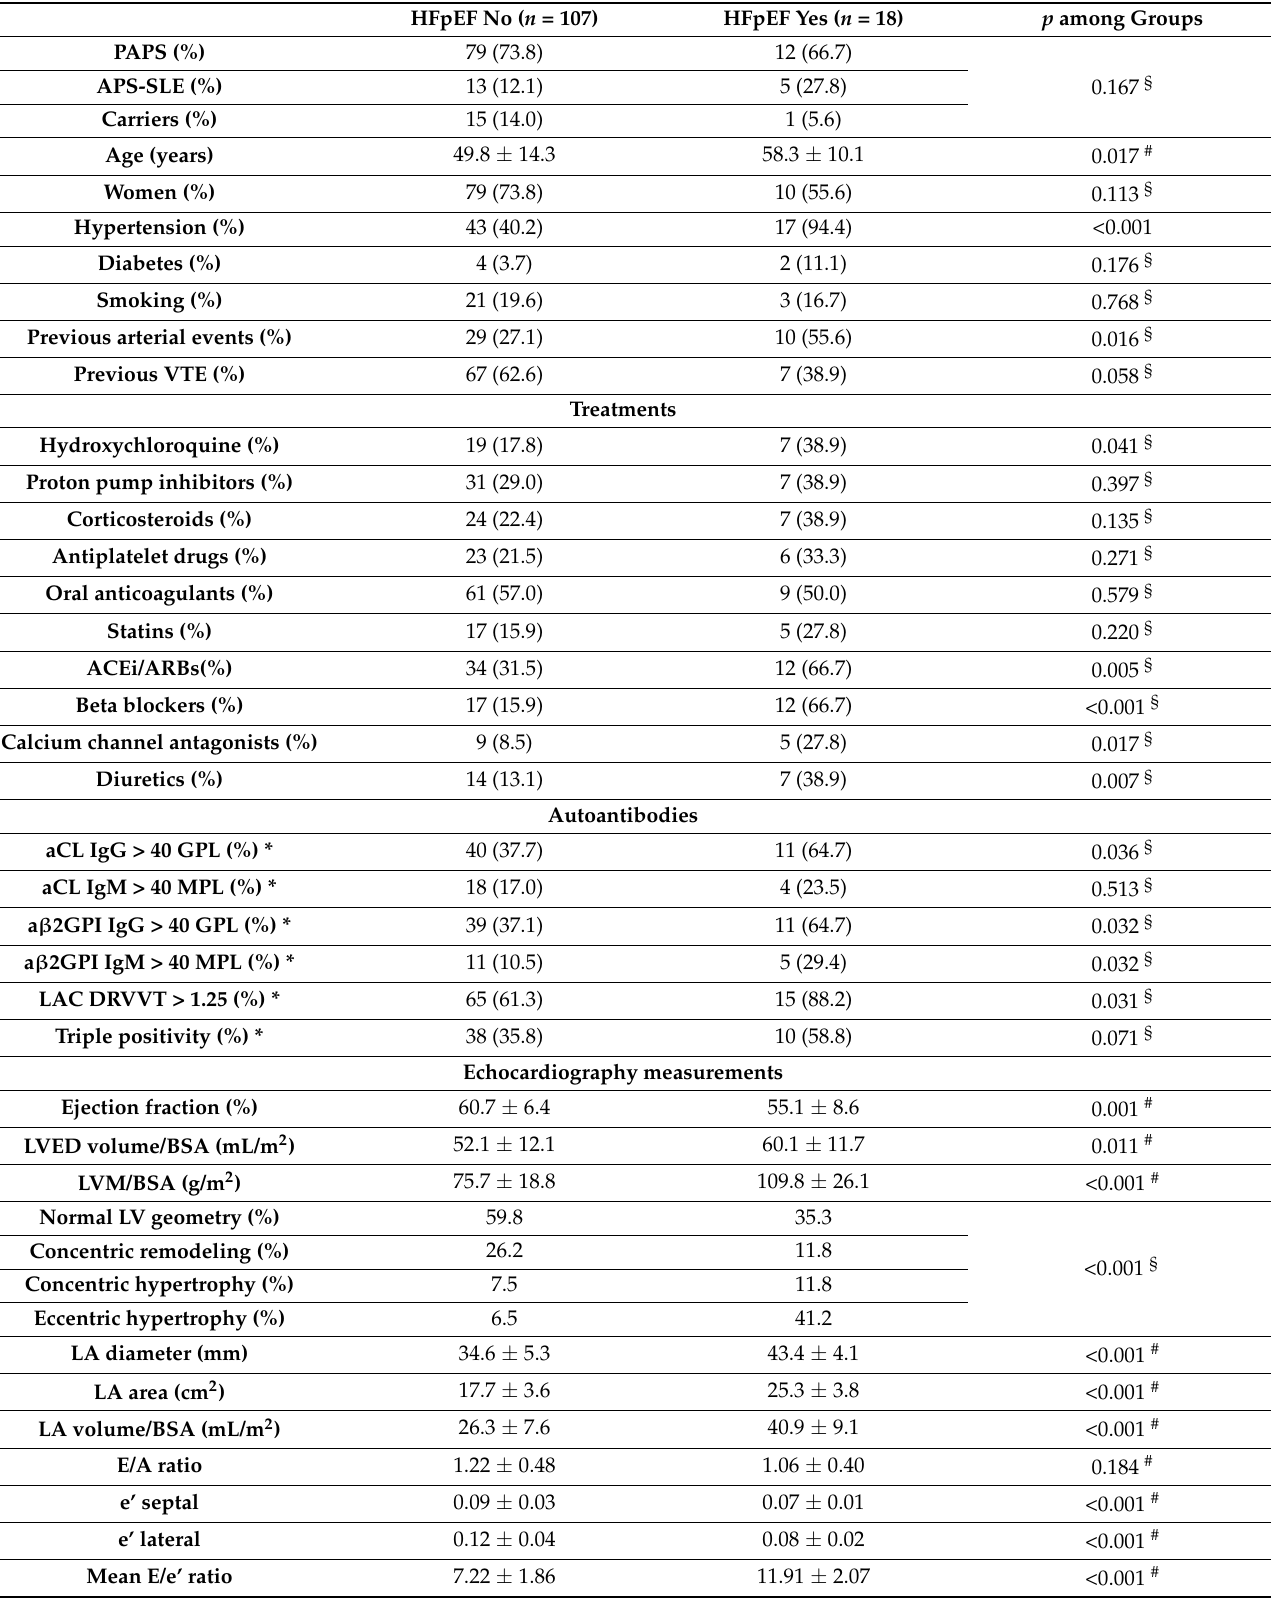
Table 2. Characteristics of patients according to the presence of heart failure with preserved ejection fraction